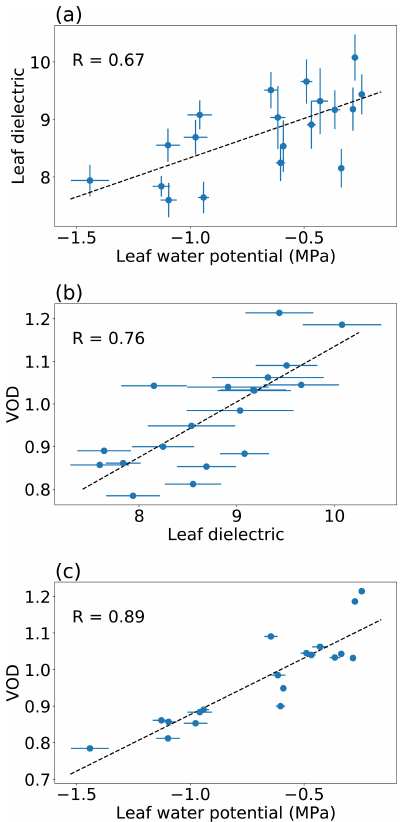
Figure 6. Scatter plots of leaf water potential, the leaf dielectric constant at the L band (real part), and VOD. Leaf measurements were taken 9–12 July. For leaf water potential, each point repre- sents a mean of several single-leaf measurements per tree from five trees. For the leaf dielectric, each point represents a mean of mea- surements from five trees, with multiple vertically stacked leaves per tree contributing to each measurement. Error bars represent 1 standard error. The dashed line represents a linear regression.